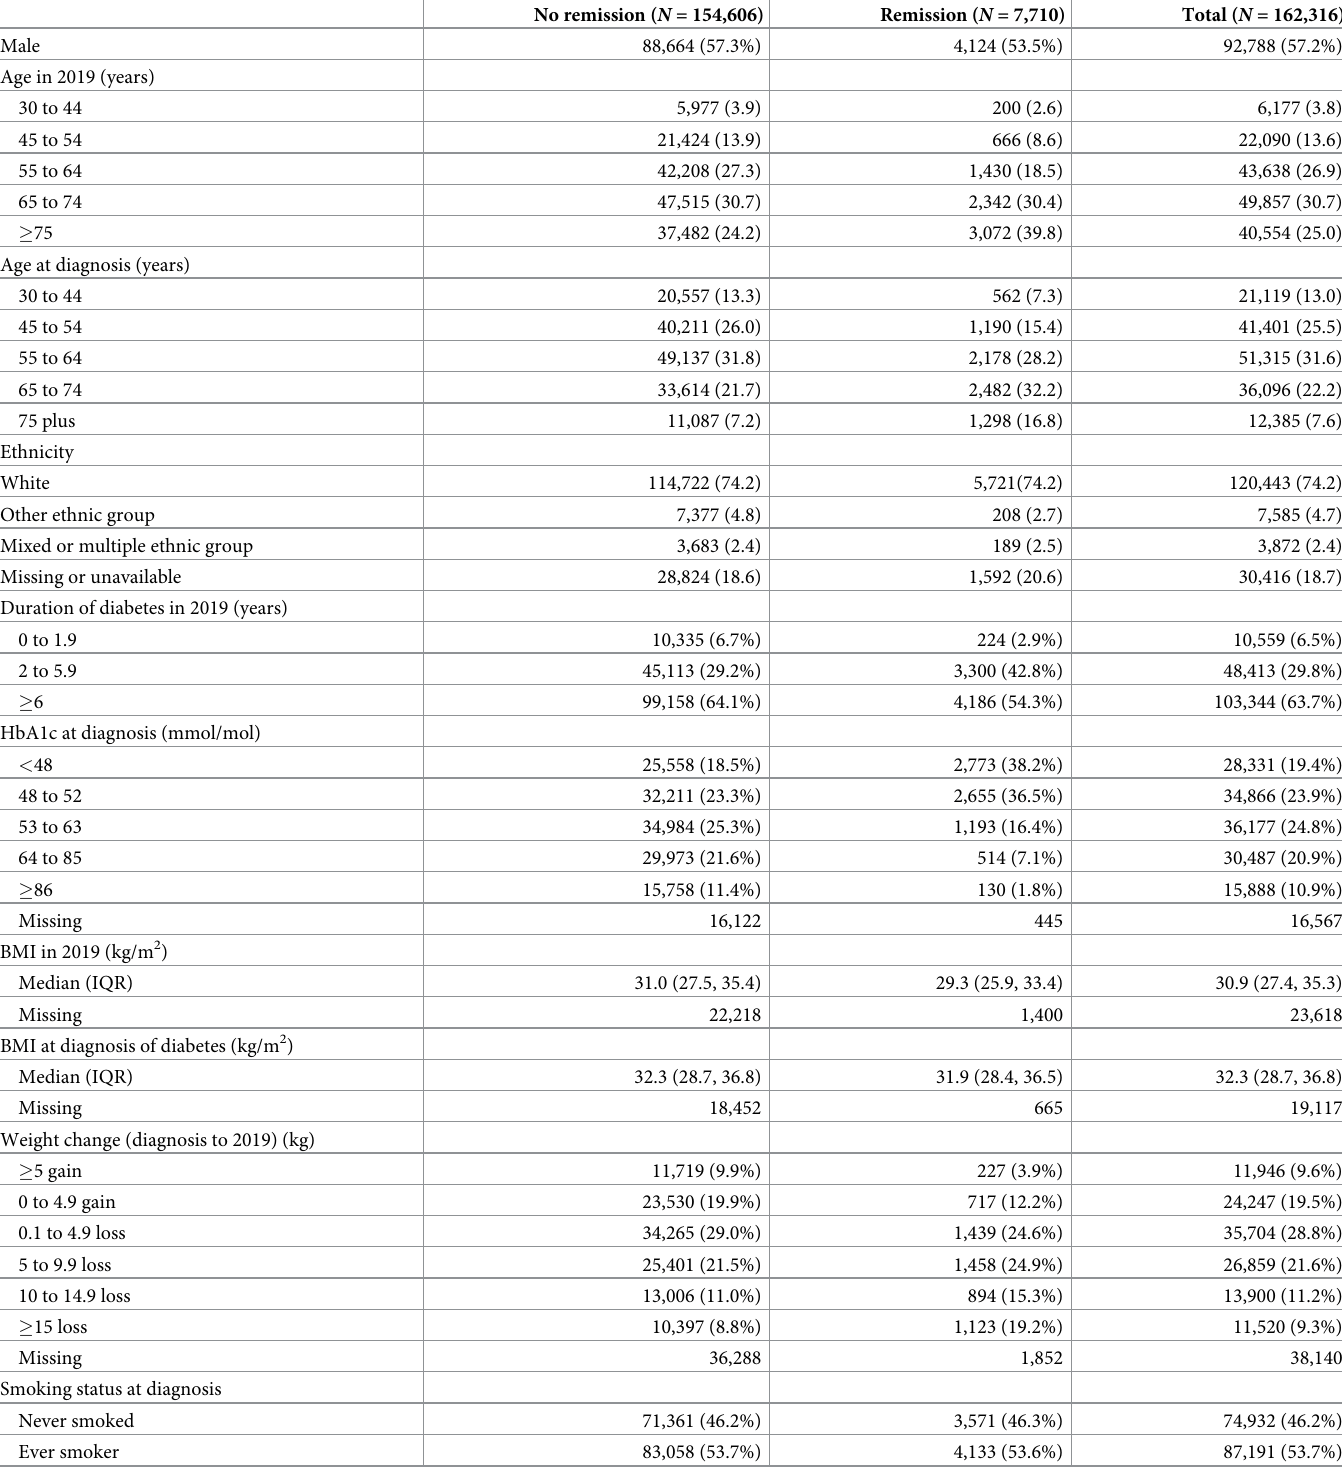
Table 1. Characteristics of people who were in remission in 2019 compared to people who were not in remission of type 2 diabetes among people in Scotland who had at least 1 HbA1c � 48 mmol/mol (6.5%) after diagnosis of type 2 diabetes and had at least 1 HbA1c recorded in